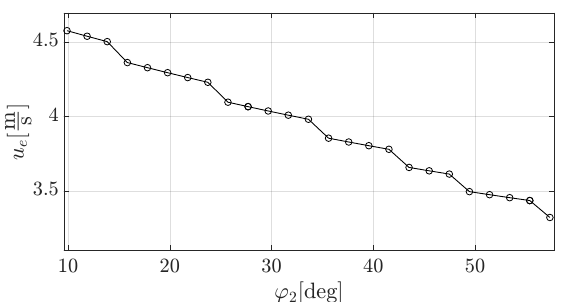
Figure 3. Entraining velocity u of the lubricant over a mesh cycle.